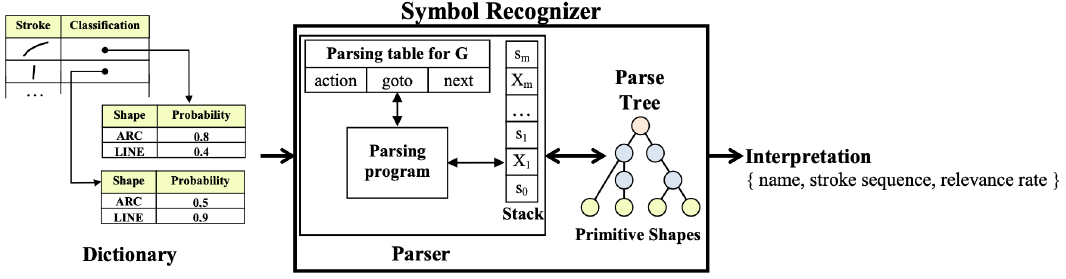
Figure 7. The architecture of a symbol